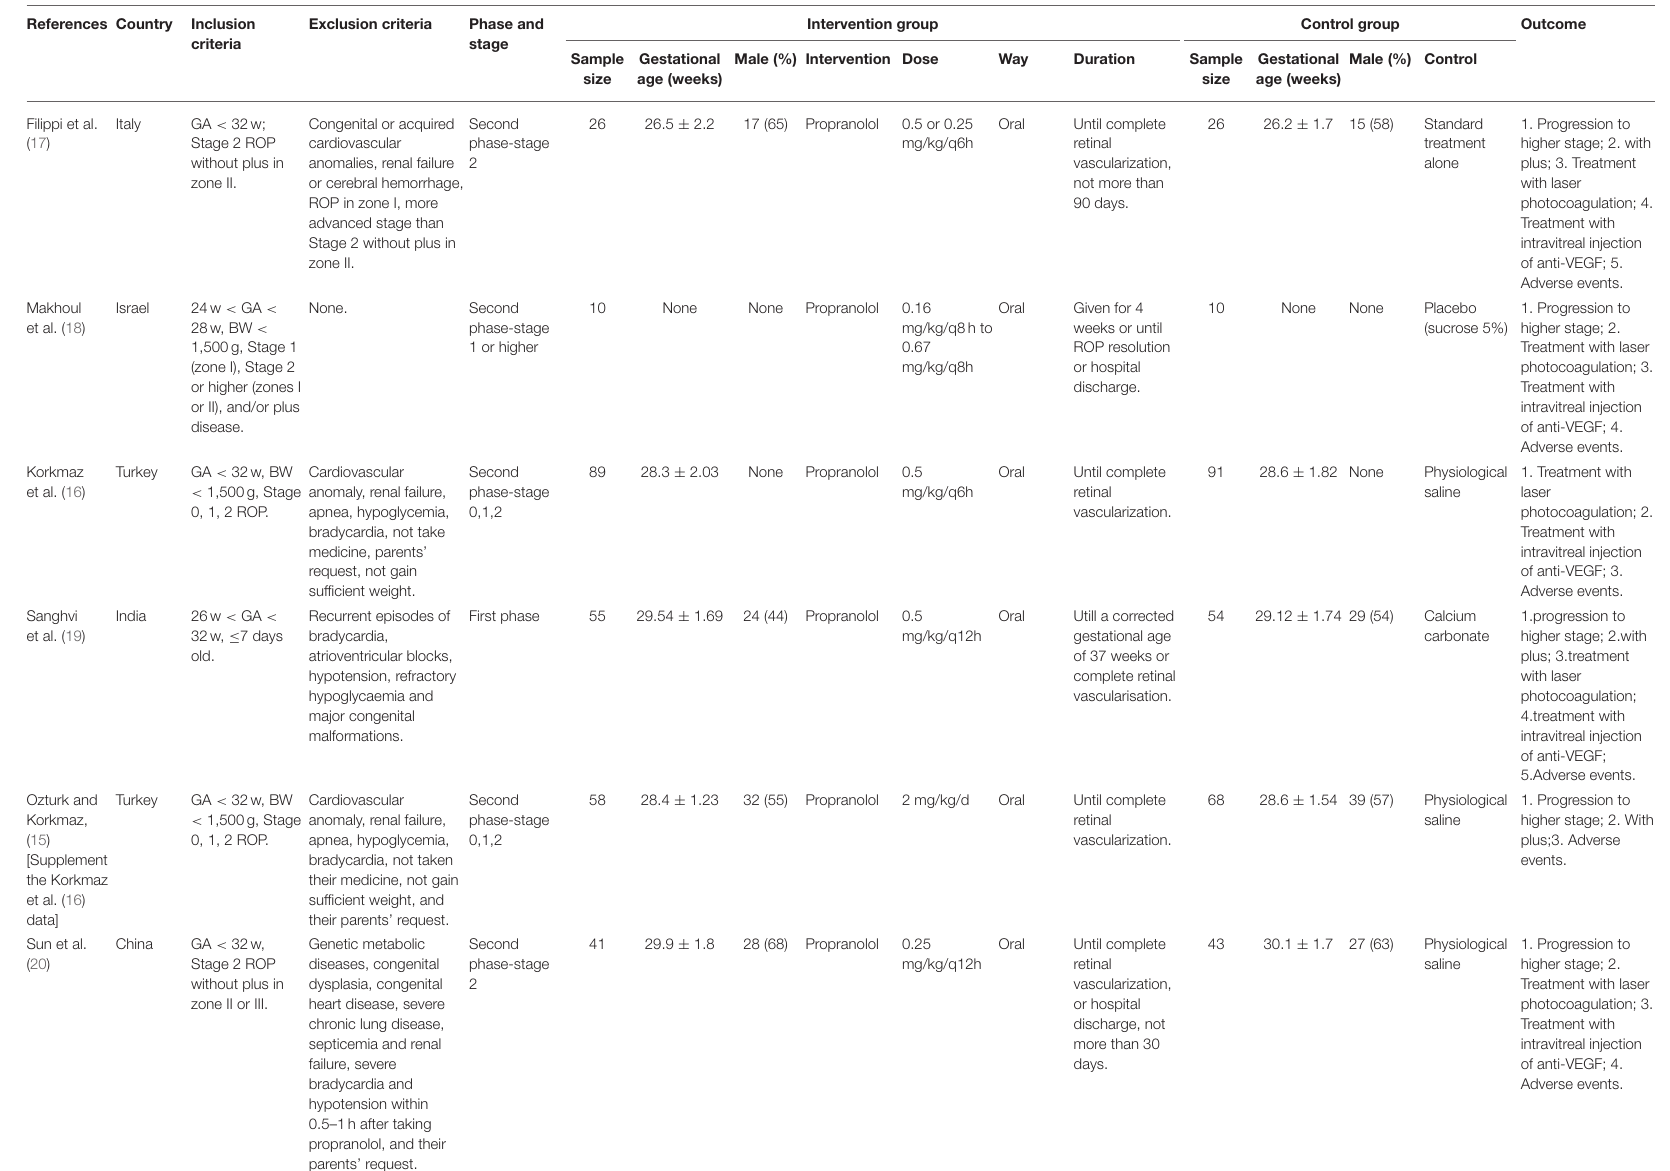
TABLE 1 | Characteristics of included randomized trials. References Country Inclusion